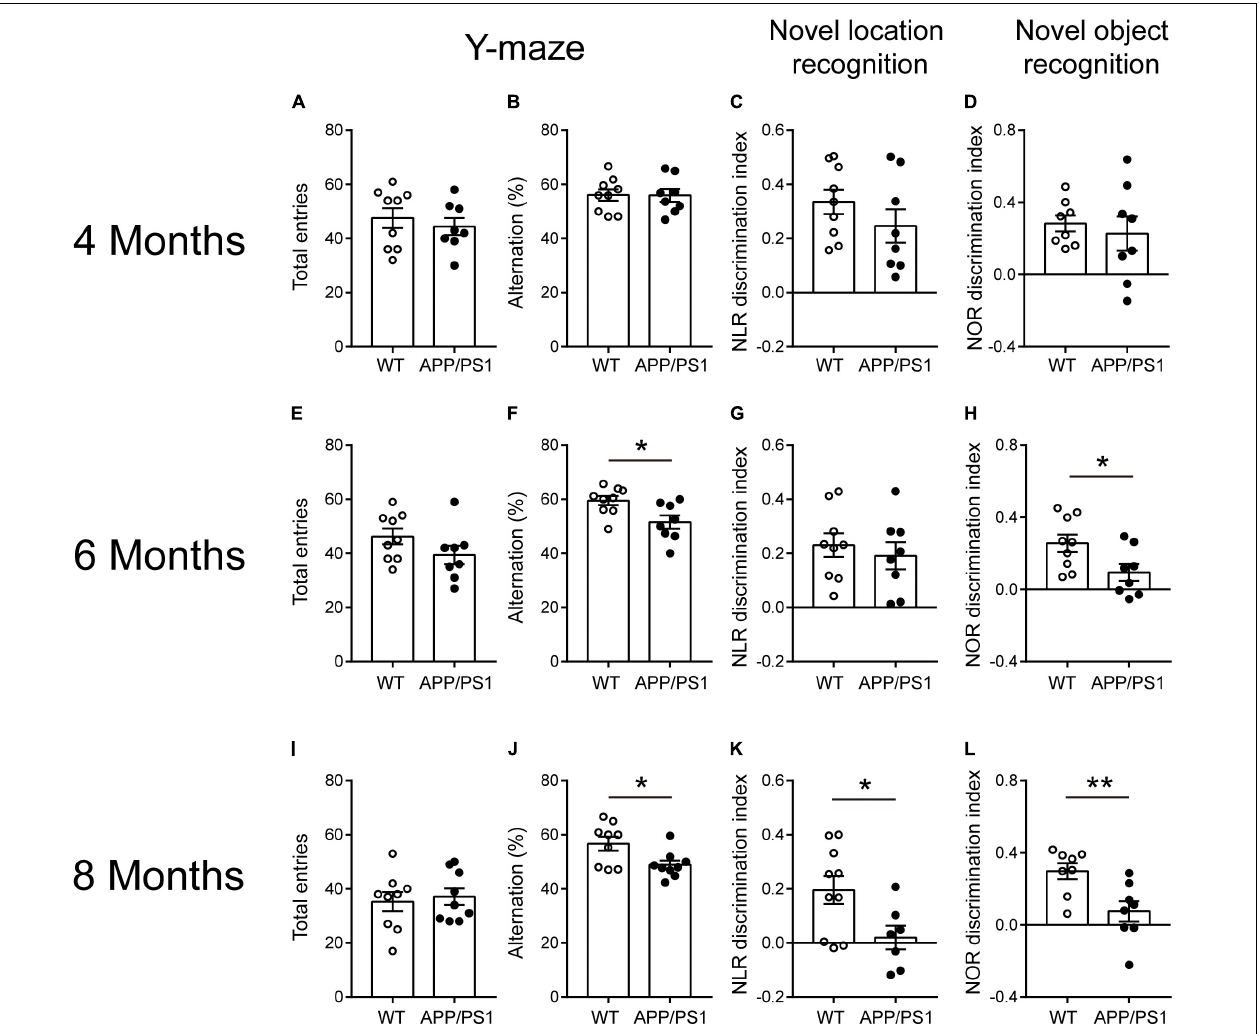
FIGURE 1 | Cognitive-behavioral performance for 4-, 6-, and 8- months-old WT and APP/PS1 mice ( n = 8–10/group). (A–D) 4-month-old WT and APP/PS1 mice showed no difference in Y-maze, NLR, and NOR tests. (E–H) In 6-month-old mice, APP/PS1 mice showed the decreased spontaneous alternations in Y-maze (* p < 0.05, unpaired t -test), reduced discrimination index in NOR (* p < 0.05, unpaired t -test) compared with WT mice, and no differences were observed in the number of total arm entries in Y-maze and discrimination index in NLR. (I–L) In 8-month-old mice, APP/PS1 mice showed the decreased spontaneous alternations in Y-maze (* p < 0.05, unpaired t -test), the reduced (* p < 0.05, unpaired t -test) discrimination index in NOR and NLR tests (** p < 0.001, unpaired t -test) compared with WT mice and there was no difference on the number of total arm entries in Y-maze.